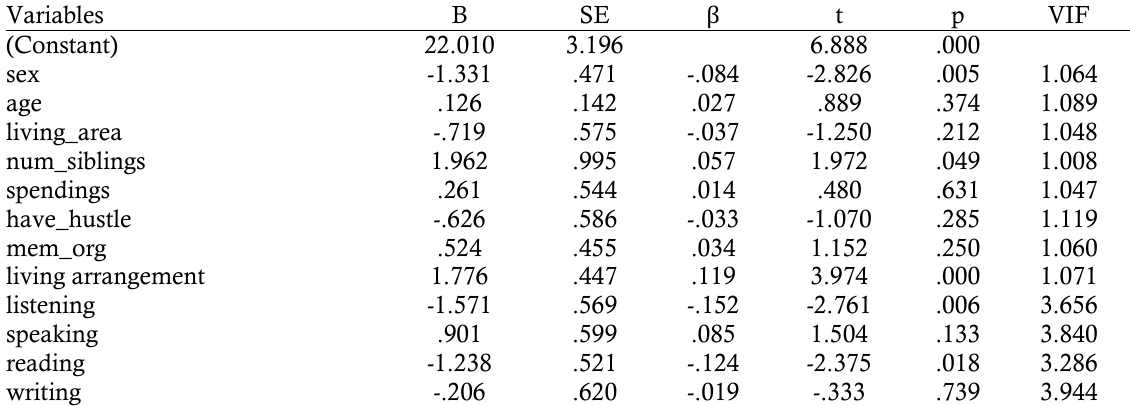
Table 3. Regression analysis to determine the impact of demographical factors and language